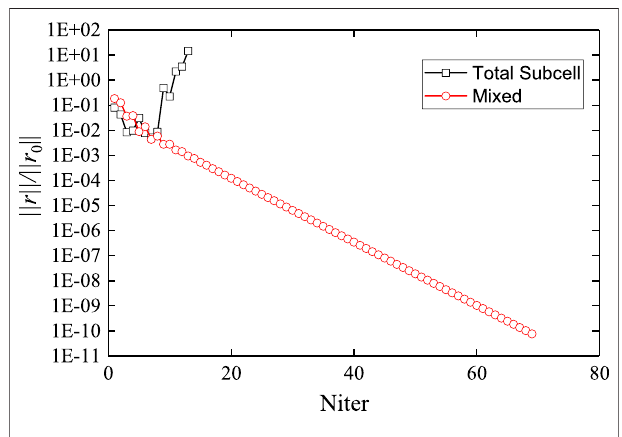
FIGURE 19 | Convergence pro fi le of the unstructured mesh for two integration